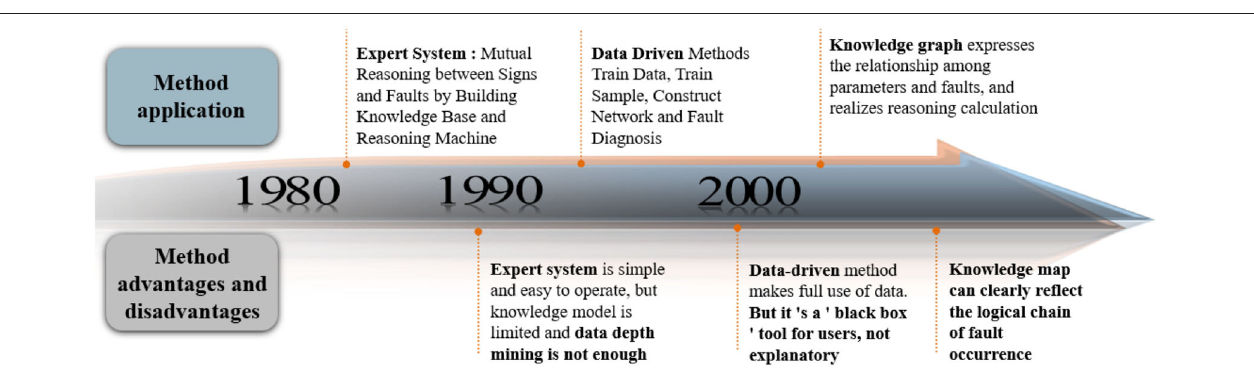
FIGURE 3 | Development history of NPP fault diagnosis